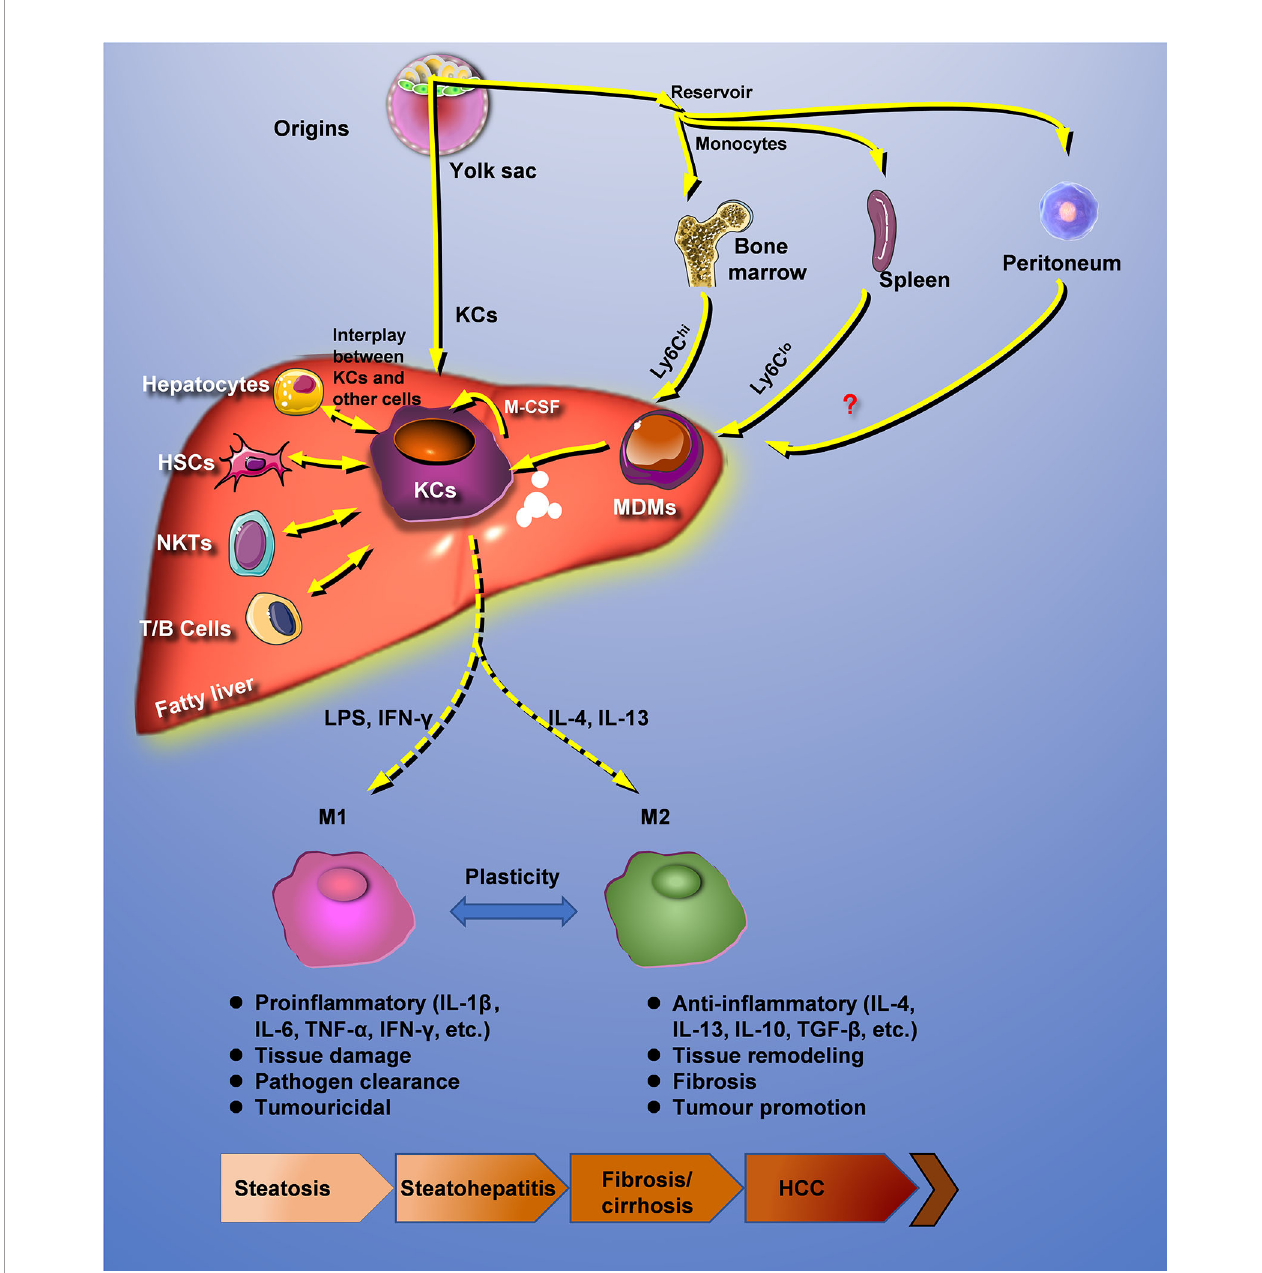
FIGURE 1 | Crosstalk with other cells and reprogramming of hepatic macrophages. Under pathologic conditions, hepatic macrophages are interacted with other cells and reprogrammed. HCC, hepatocellular carcinoma; HSCs, hepatic stellate cells; KCs, Kupffer cells; MDMs, mononuclear-derived